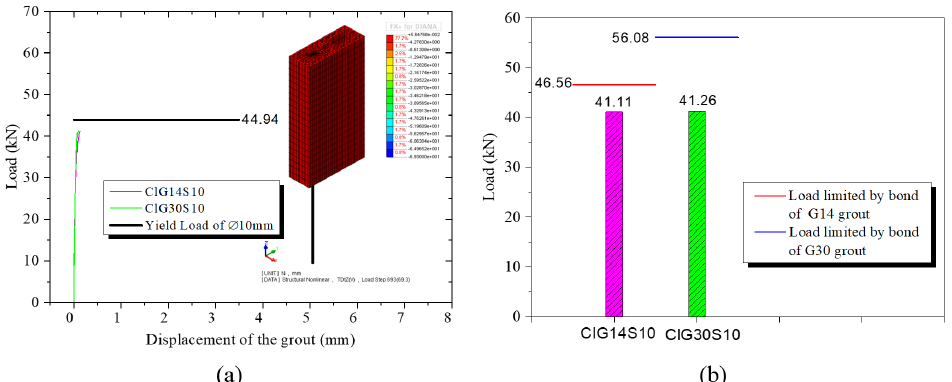
Figure 17. Pull-out tests with rebar diameters of Ø10 mm (a) parametric results (load vs displacement diagrams) and (b) maximum